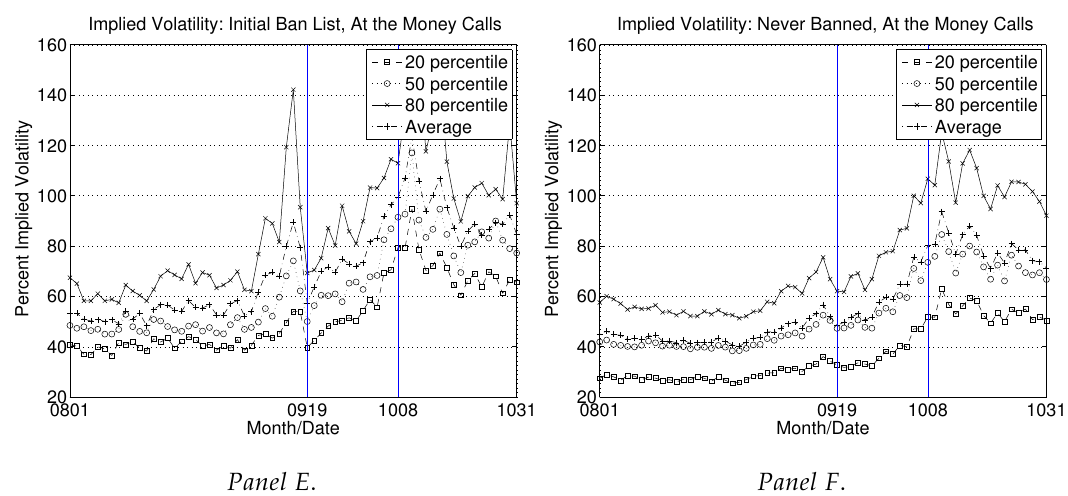
Figure 3. Time series of cross sectional options summary statistics: At the money call options of Initial Ban List and Never Banned Stocks during the ban and non-ban periods: ( A , C , E ) results for the three variables for Initial Ban List Stocks; and ( B , D , F ) results for the three variables for Never Banned